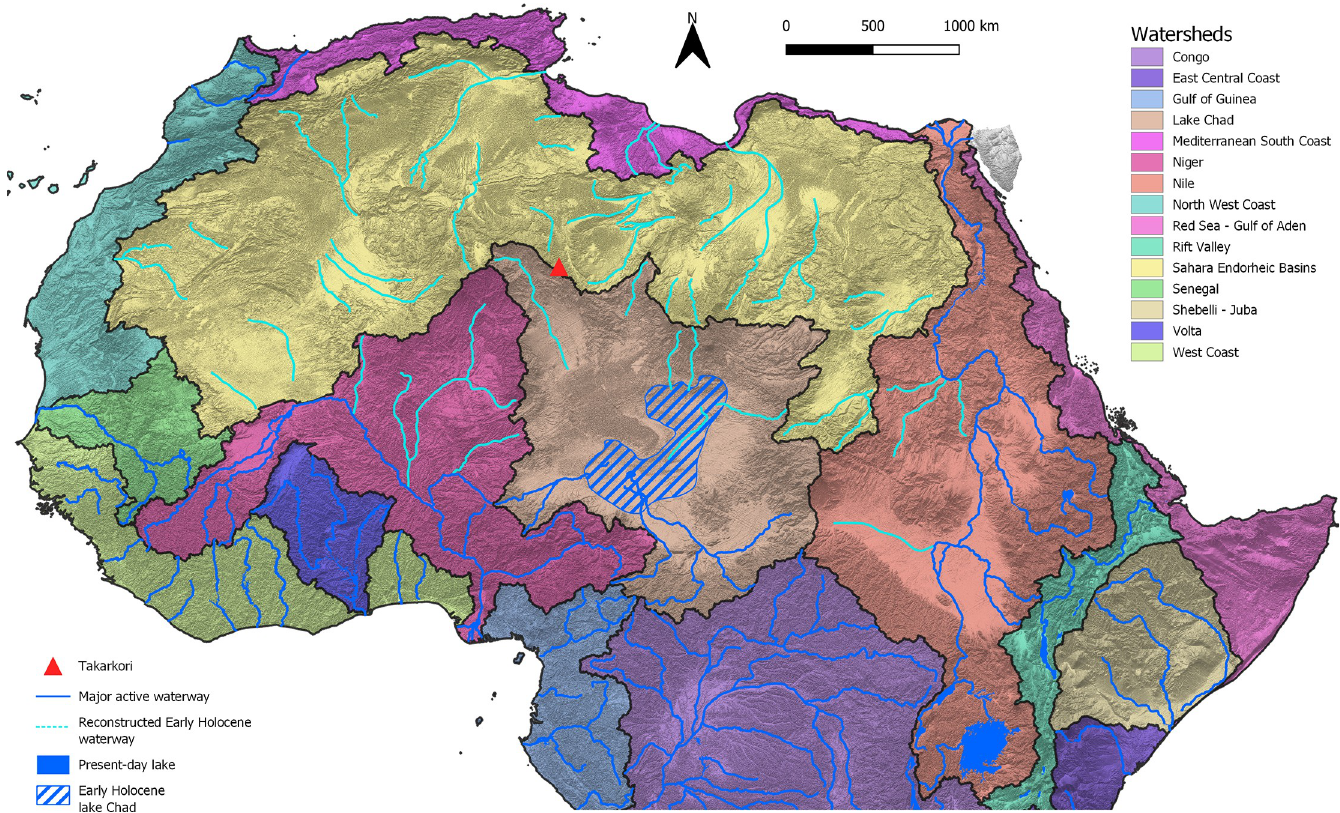
Fig 13. Reconstruction of the main active and fossil North African hydrographic basins elaborated from HydroSHEDS (www.hydrosheds.org).